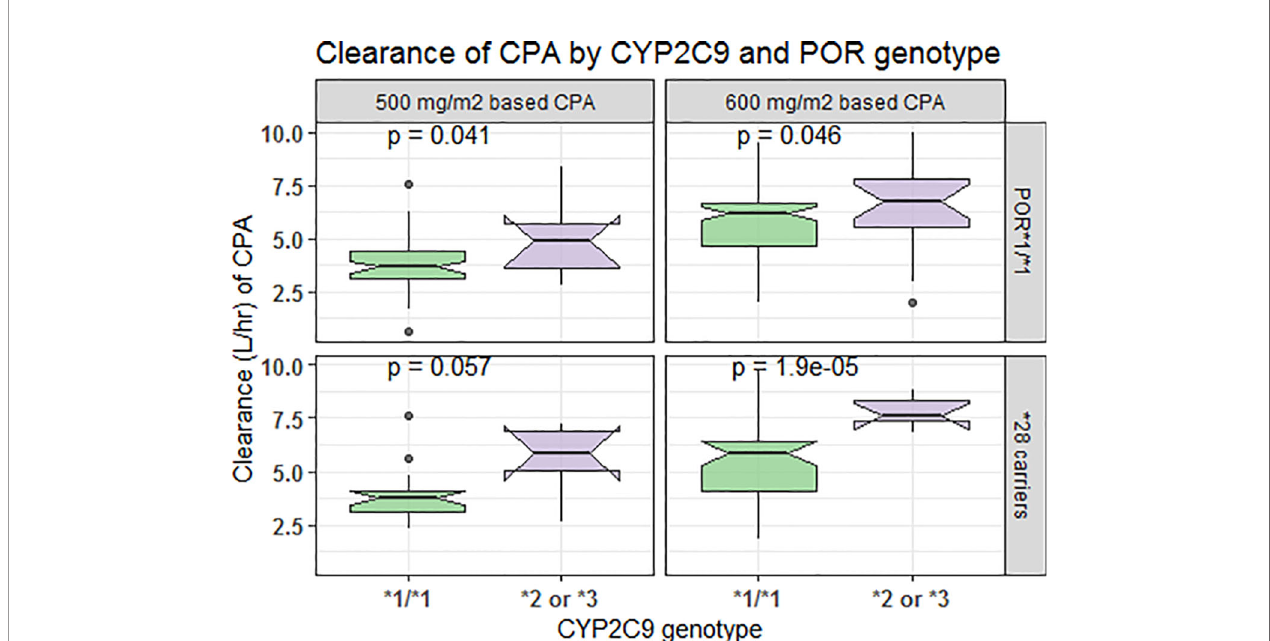
FIGURE 6 | Comparison of clearance of cyclophosphamide by CYP2C9 and POR